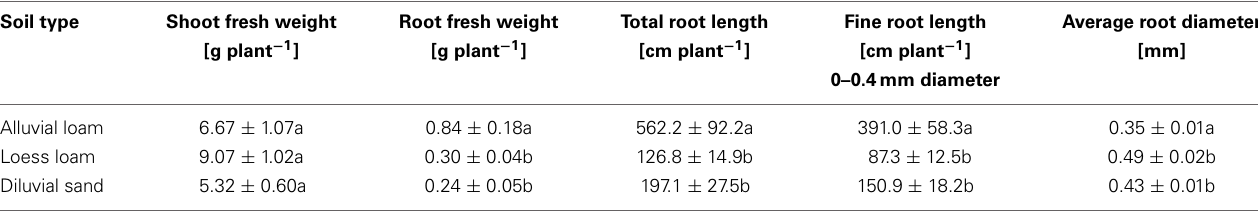
Means ± SE of four independent replicates. In each column different characters indicate significant differences (One-way ANOVA, Holm-Sidak test, p = 0.05).